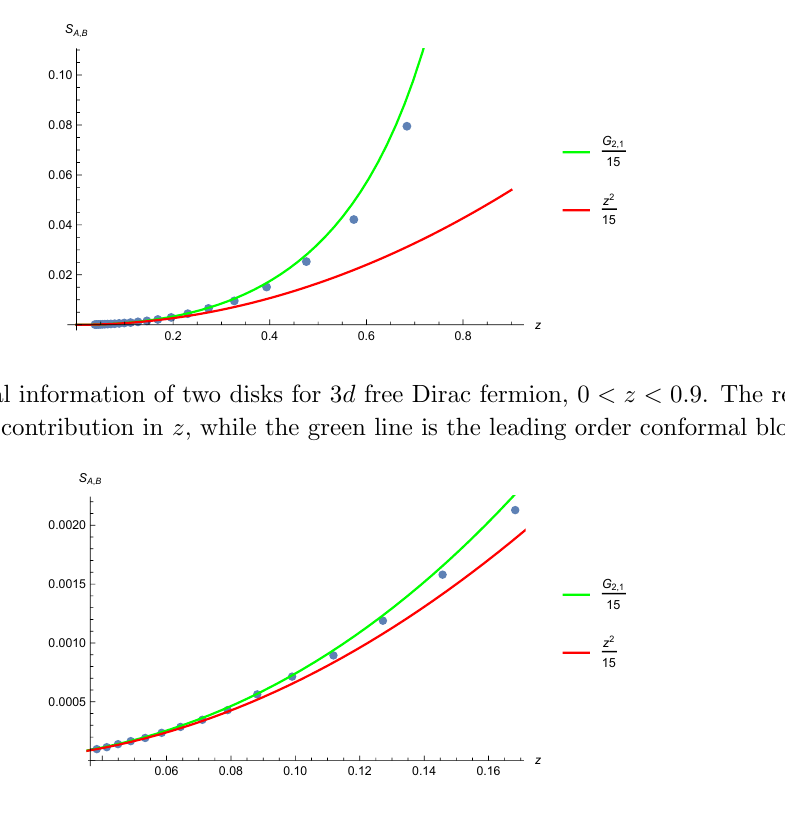
Figure 7 . Mutual information of two disks for 3 d free Dirac fermion, 0 < z < 0 : 17. The red line is the leading order contribution in z , while the green line is the leading order conformal